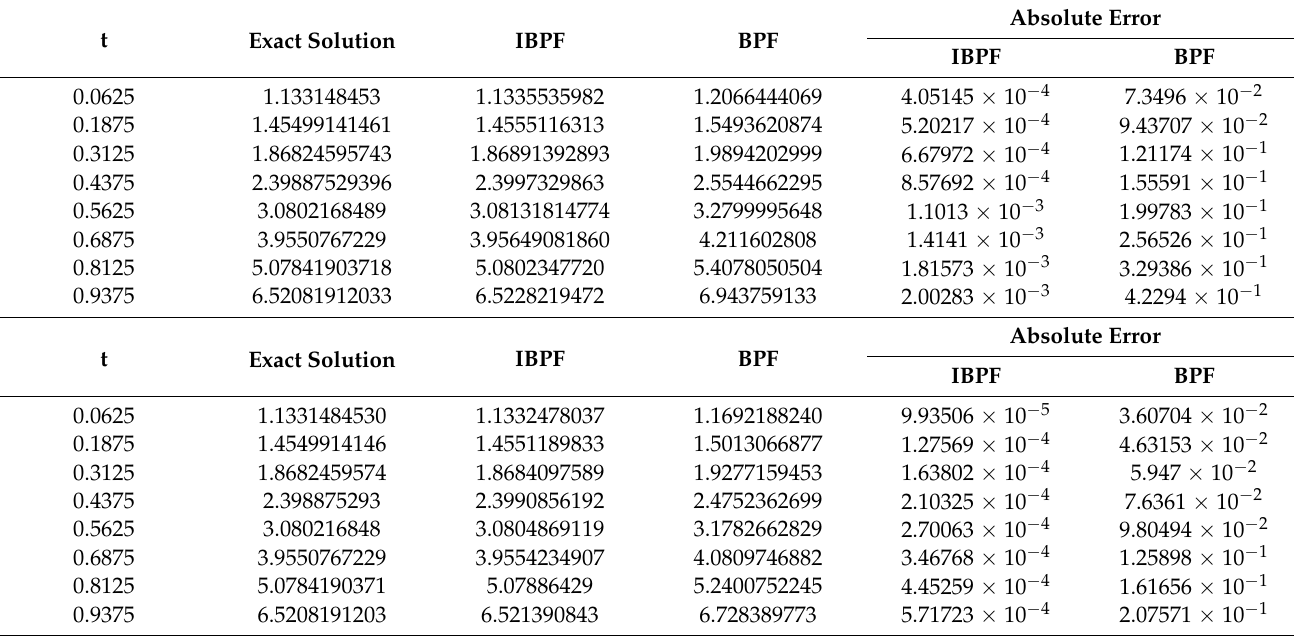
Table 2. The numerical results of example 2 at m = 16 and